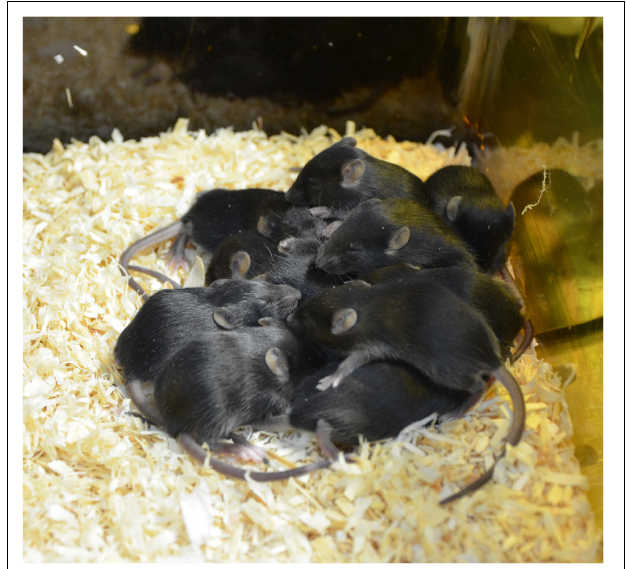
FIGURE 4 | An example picture of pups derived by transferred embryos obtained after IVF with GO treated spermatozoa.